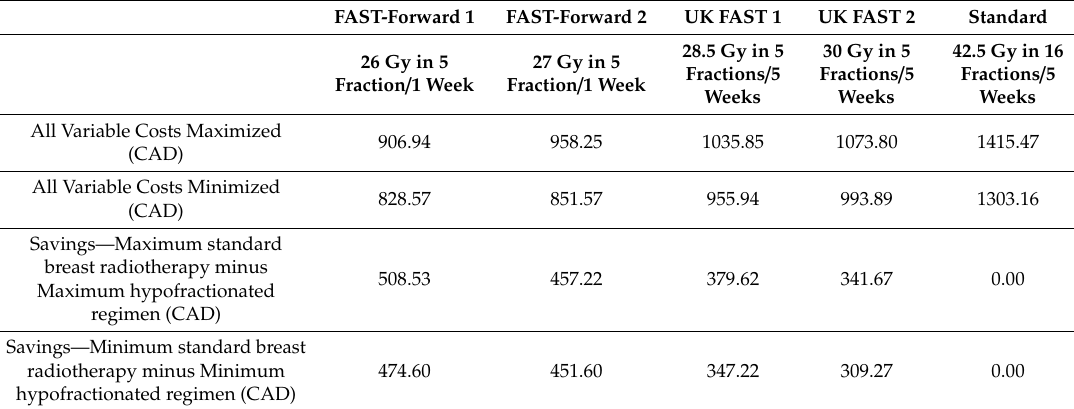
Table 4. Sensitivity